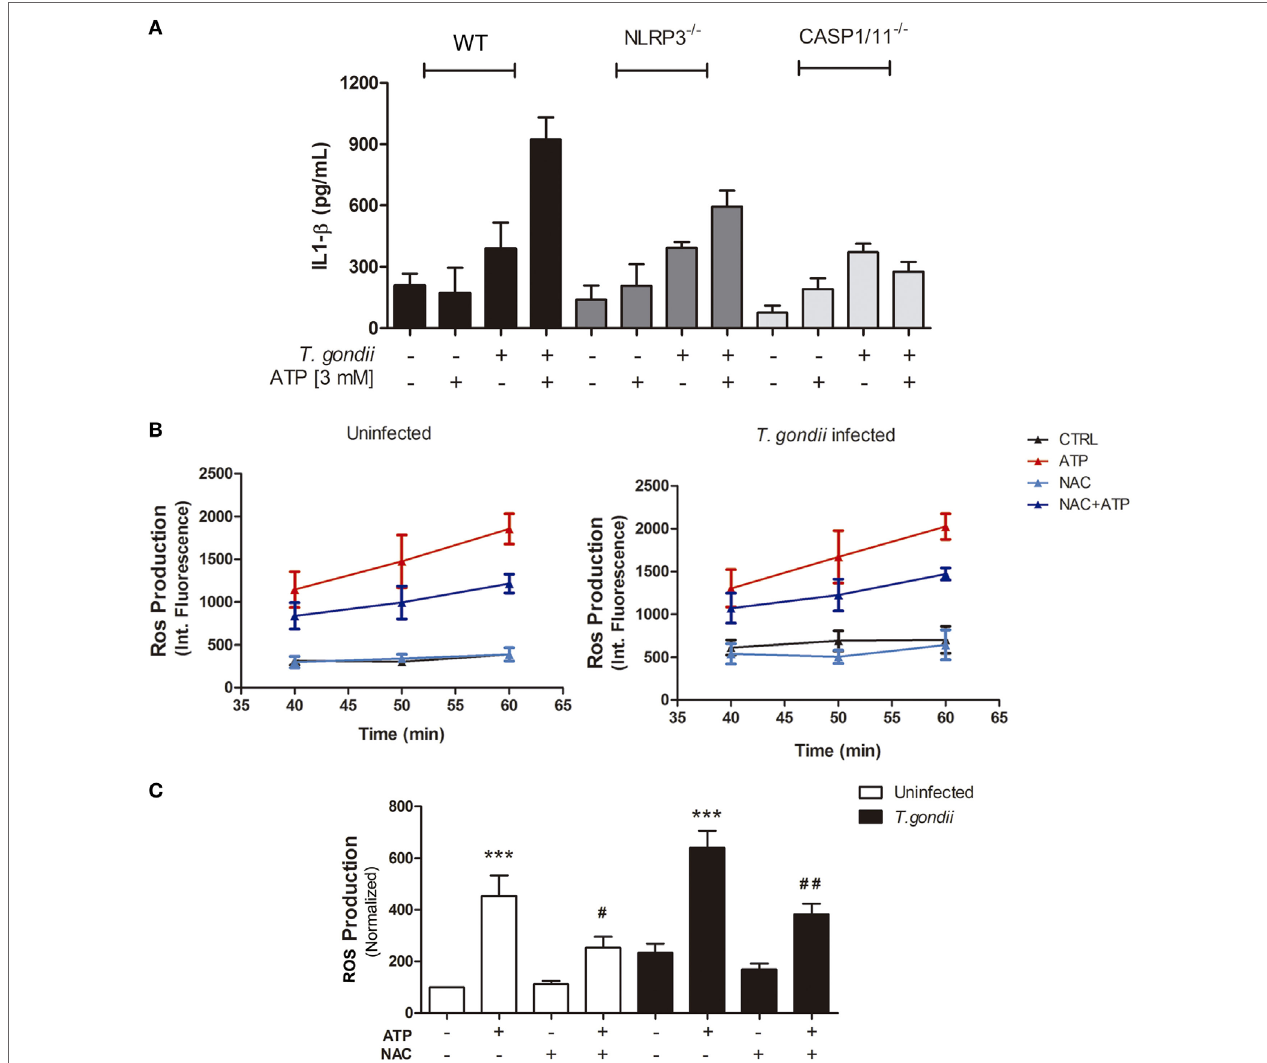
FigUre 4 | Extracellular ATP (eATP) is important for IL-1 β secretion via canonical NLRP3 inflammasome induction and reactive oxygen species (ROS) production, in T. gondii- infected macrophages. Bone marrow-derived macrophages from C57BL/6 (WT), NLRP3 − / − or Caspase-1/11 − / − mice, either uninfected or infected with T. gondii tachyzoites, were kept untreated or were treated with ATP, and then culture supernatant samples were used to estimate IL-1 β secretion (a) . Treatment with 3 mM eATP (for 30 min) was performed 2 h post-infection, and all cells were incubated for 24 h prior to IL-1 β quantification. Data represent mean ± SEM from triplicates. For ROS detection, before eATP treatment, some cultures were incubated with 10 mM N -acetyl cysteine (NAC) and ROS production was detected. (B,c) ROS levels in cells treated for 30 min, with NAC and then with 3 mM eATP (for up to 60 min), 2 h post-infection. ROS levels were estimated by H 2 DCFDA fluorescence, at different time-points during treatment with eATP (B) , with normalized data from the 50-min time-point in (c) . Data represent mean ± SEM of three independent experiments performed in triplicates. # p ≤ 0.05 and ## p ≤ 0.01 vs. corresponding samples treated with eATP only; *** p ≤ 0.001 vs. the corresponding untreated control (by one-way ANOVA followed by Tukey’s